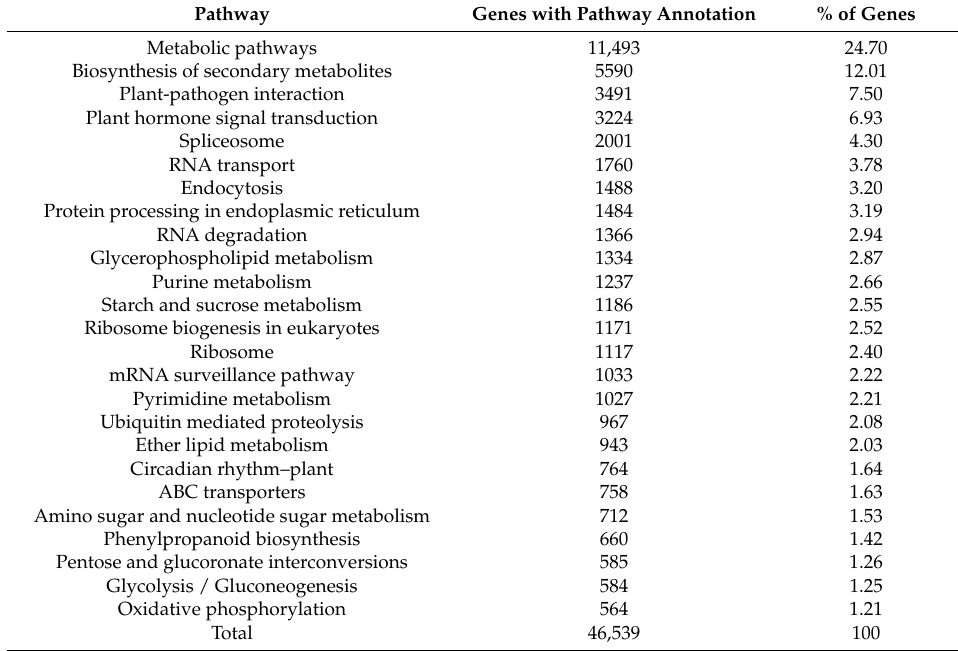
Table 5. Number of impatiens unigenes involved in top 25 pathways listed by KEGG database.